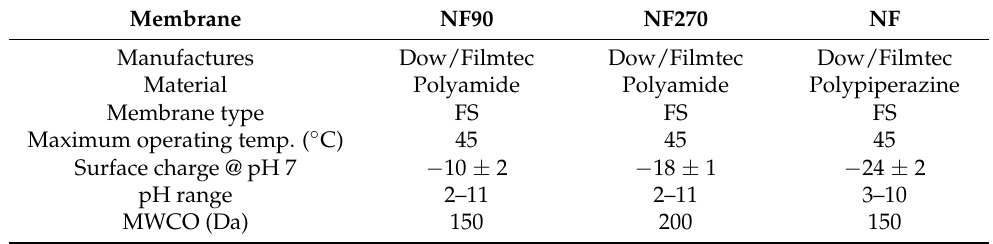
Table 1. Properties of different nanofiltration membranes and their suppliers. Membrane